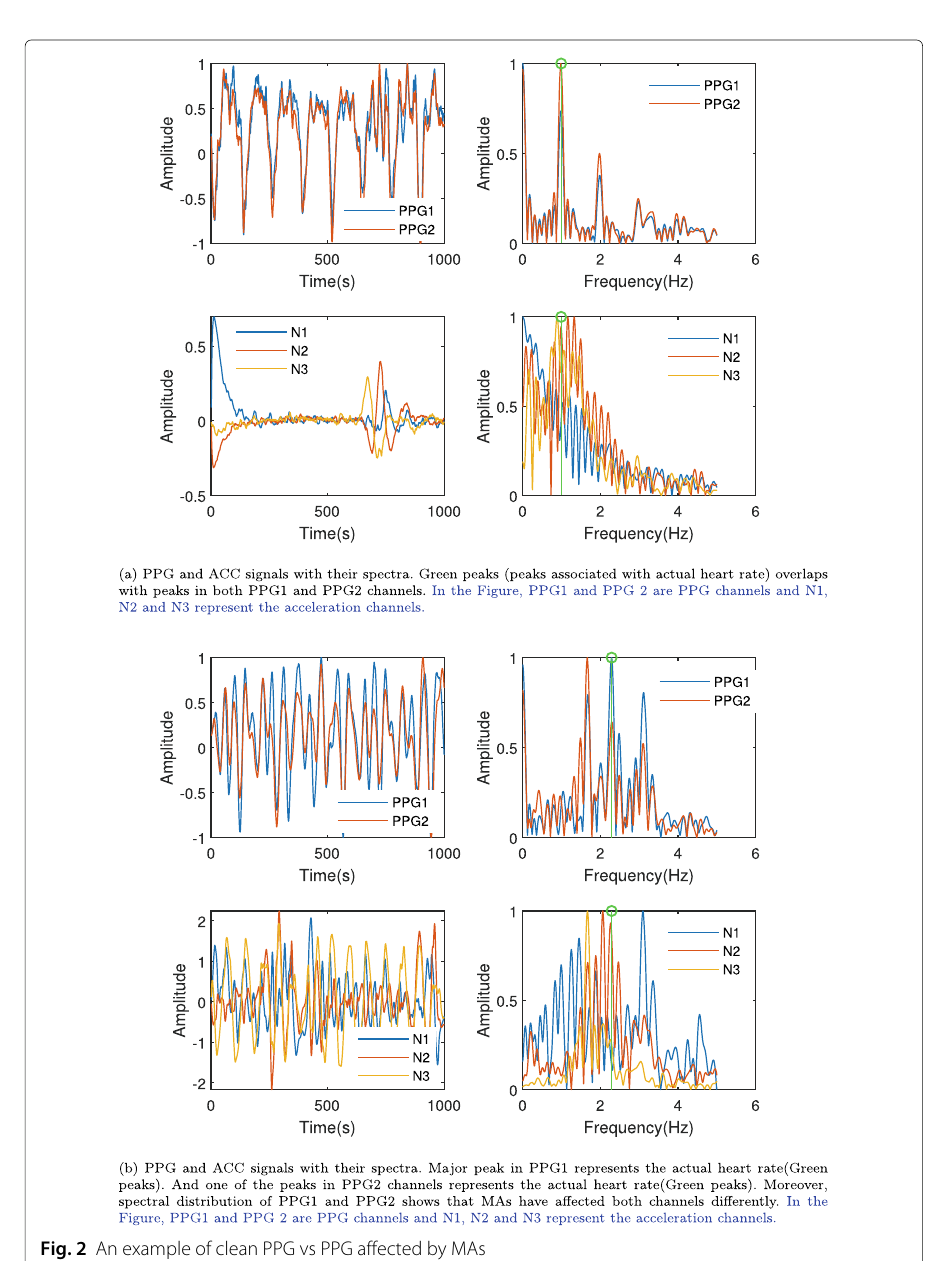
in PPG1 and a minor peak in PPG2 represent the actual heart rate. In Fig. 3a, one of the minor peaks in PPG1 represents the actual heart rate. But PPG2 does not have a single peak which could represent the actual heart rate. Moreover, MAs in ACC channels appear directly in PPG channels. Finally, in Fig. 3b, both channels are devoid of peaks which could represent the actual heart rate. Moreover, both PPG channels in Figs. 2b and 3a, b are affected differently due to the intensity and type of exercise that the person was doing. Due to high probability of proximity of HR and MA spectral peaks and spectral peak ran- domness, removal of MAs is the single most important preprocessing step in classical signal processing to calculate HR calculation from